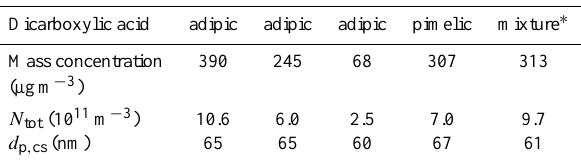
Table 1. Experimental matrix for equilibration time scales investi- gation.